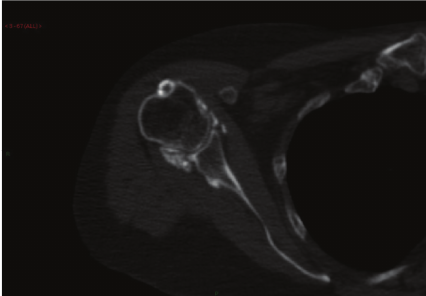
Figure 2: CT scan of the right shoulder confirmed intra- and extra- articular